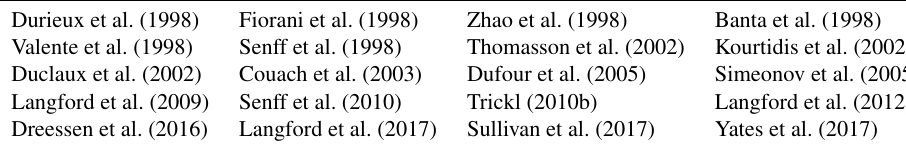
Table A2. List of citations for air-quality studies including ozone lidar systems.